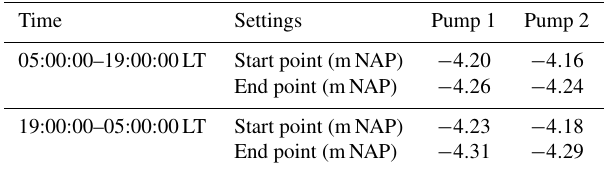
Table 1. Pumping scheme of polder